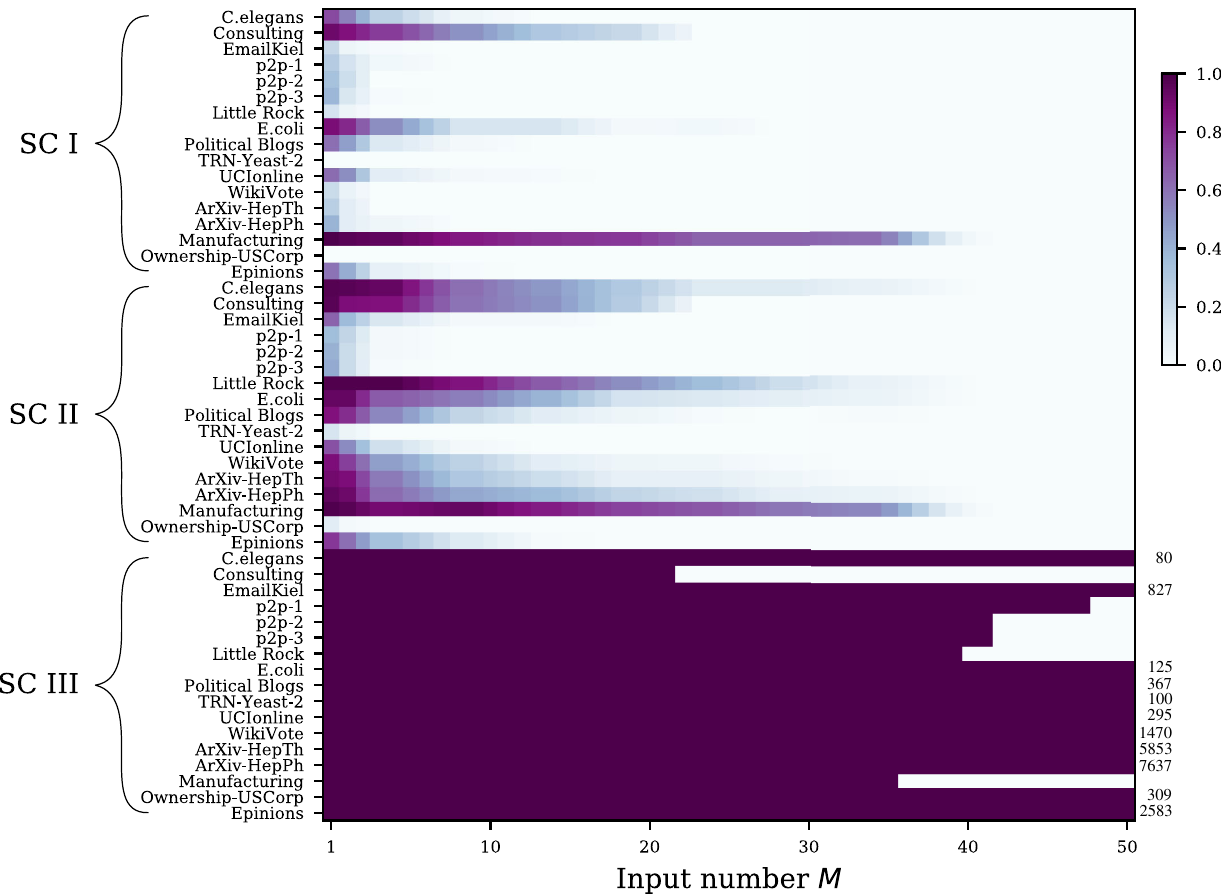
FIG. 12. A heat map comparing the probability ofinvertibility ρ for the networks in Table I with three different node selection schemes as a functionofthenumberofinputs.ScenarioSCI,whereneitherinputsnoroutputscanbeselected,issimulatedbyuniformrandomsamplingof input and output nodes [the same data as in Fig. 9(a)]. In scenario SC II, we are able to select the output nodes, and the results for the optimal sensornodeplacement from Fig.11(a)are includedforcomparison.Under scenarioSCIII,wecanselect bothinput andoutputnodes.We use hub input selection (selection of nodes with highest out degree) in combination with optimal sensor node placement and find that ρ is either one or zero. The numbers on the right indicate the maximum number M of inputs which still provide an invertible max